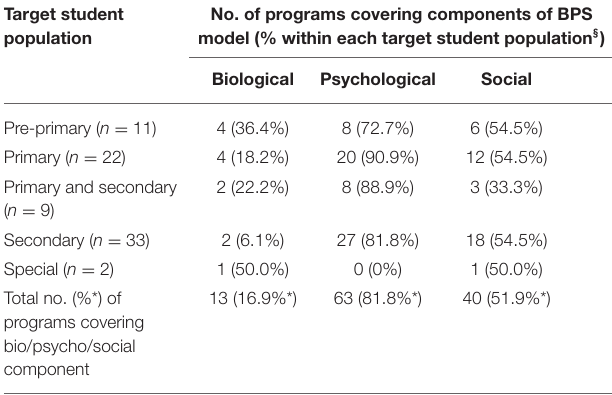
of a single-, dual-, or multi-component approach was analyzed ( Figure 1 ). Out of the 77 programs, 43 (55.8%) adopted only one single component of the BPS framework, 29 (37.7%) covered two